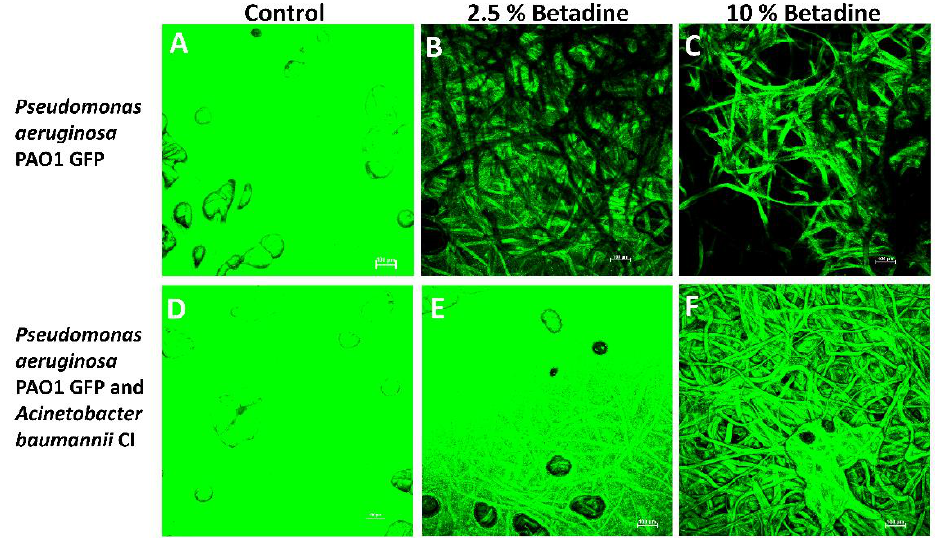
Figure 4. Confocal laser scanning microscopy of the P. aeruginosa PAO1 GFP grown alone ( A – C ) and P. aeruginosa PAO1 GFP and A. baumannii CI grown together ( D – F ) that remained on the disc after treatment with Betadine.